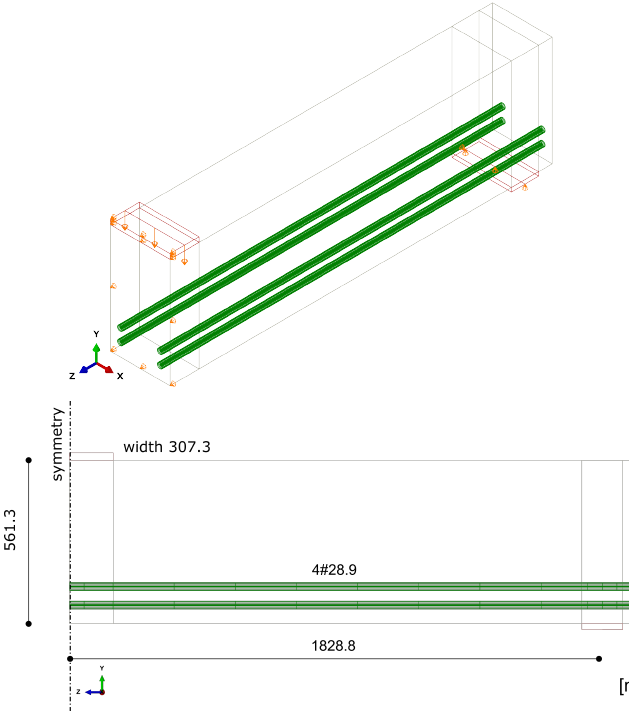
Figure 21. OA-1 beam—dimensions and boundary conditions assumed in the analysis.